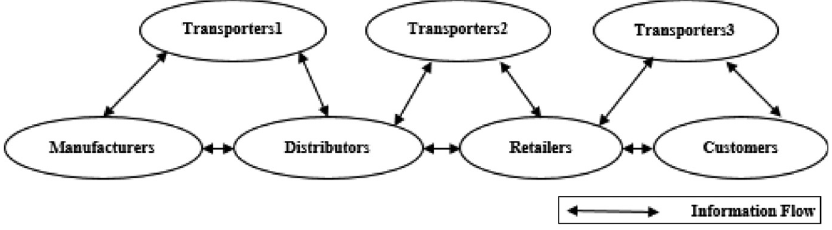
Figure 5. A generalized supply